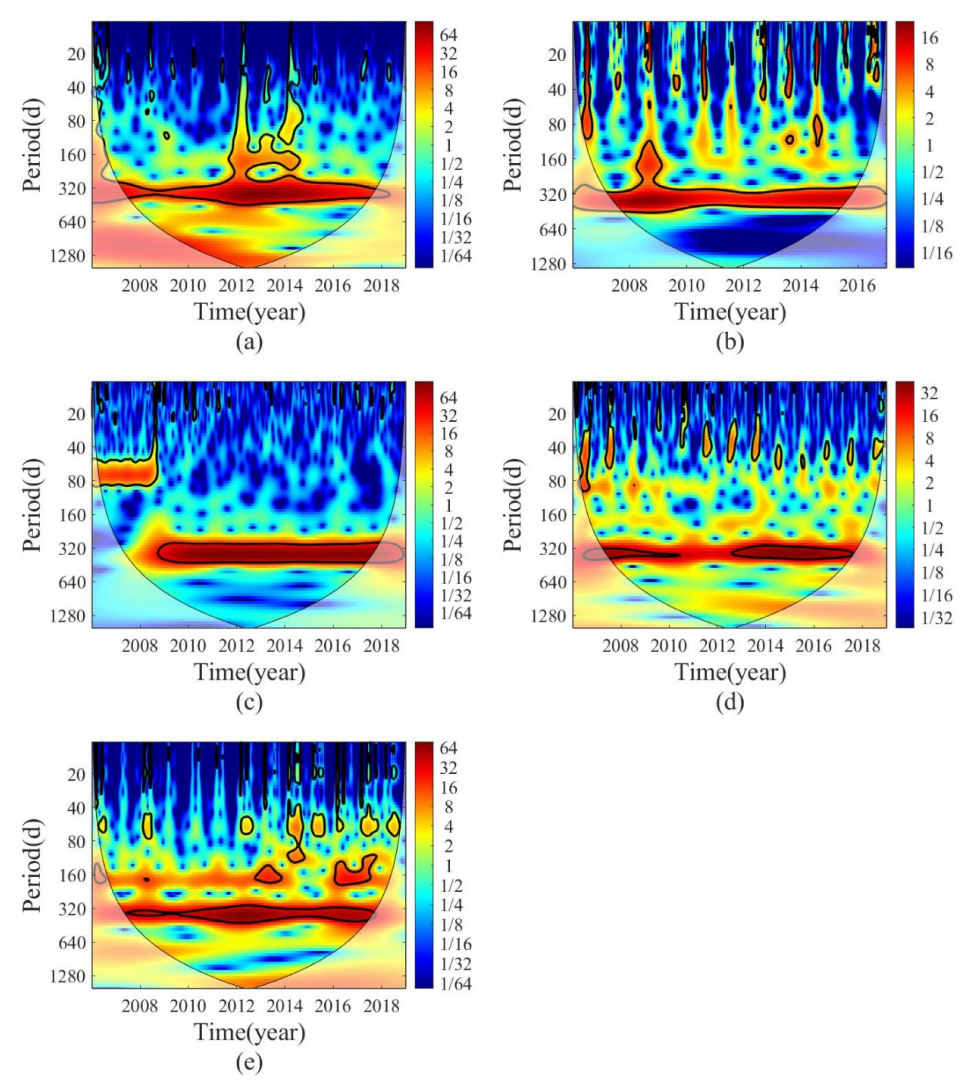
Figure 7. The continuous wavelet power spectrums of different time series during the period of 2006–2018: ( a ) Groundwater level; ( b ) Precipitation; ( c ) Air temperature; ( d ) Water stage of the Yellow River; ( e ) Well irrigation water